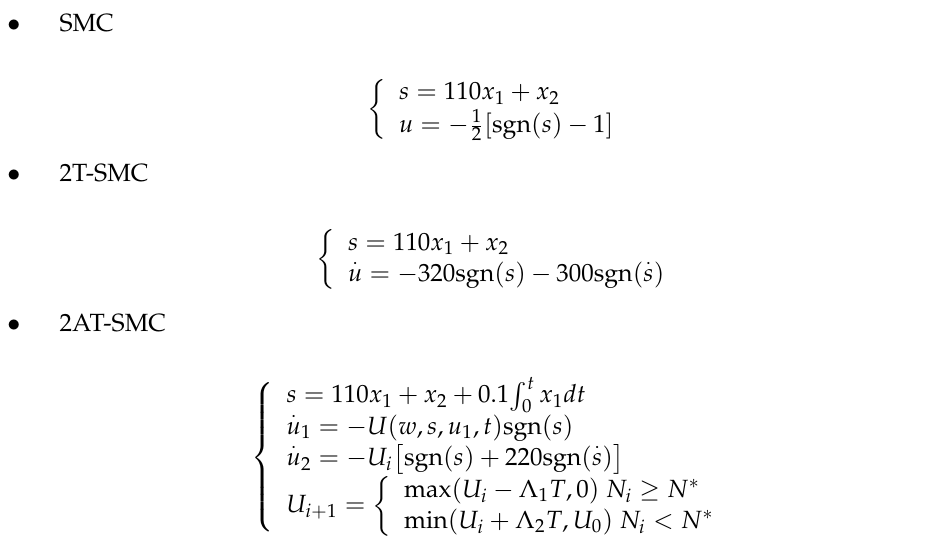
Table 1. Circuit parameters of the buck converter. Symbols Parameters Values L Inductance 1 mH C Capacitance 1000 µ F R Load resistance 10 Ω V ref the Reference voltage 5 V E Input DC voltage 10